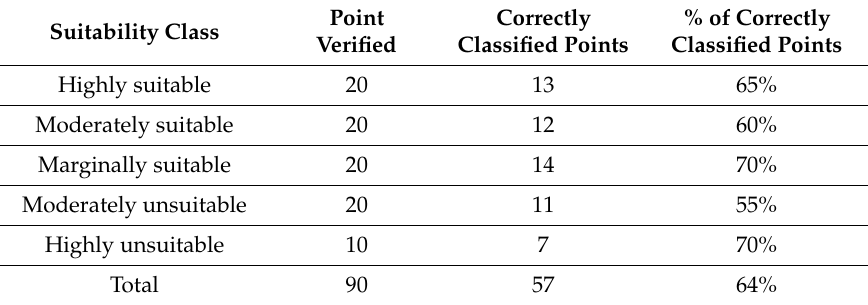
Table 6. Accuracy